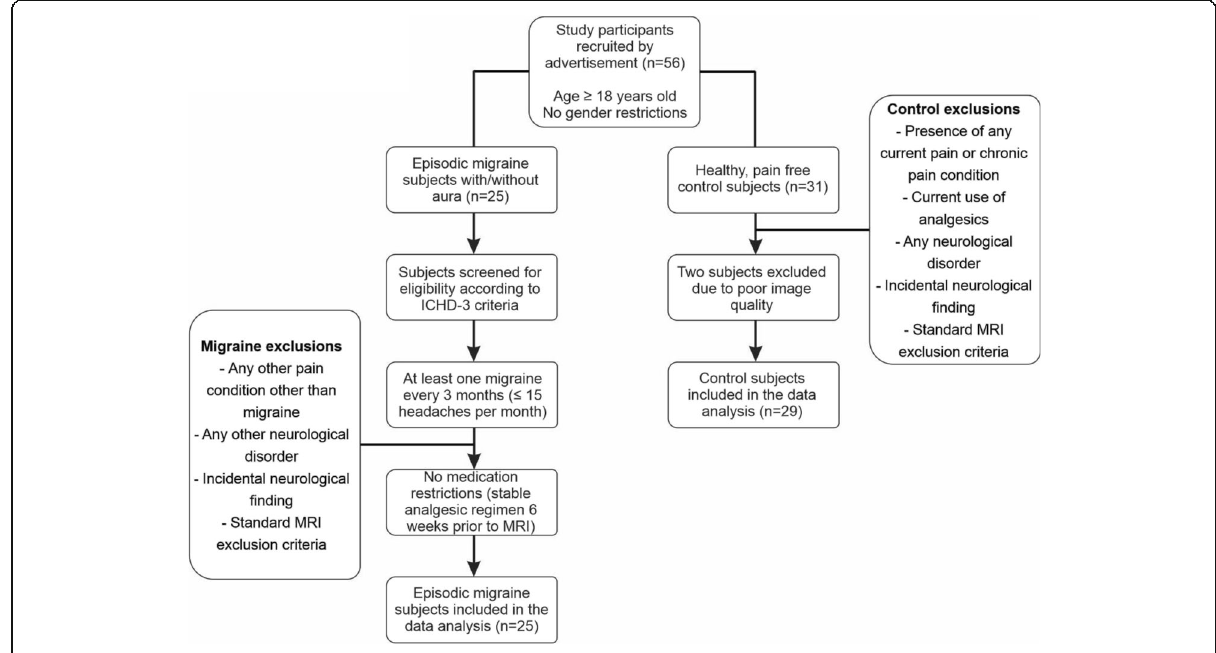
Fig. 1 Flow chart of the inclusion and exclusion criteria of control and episodic migraine study